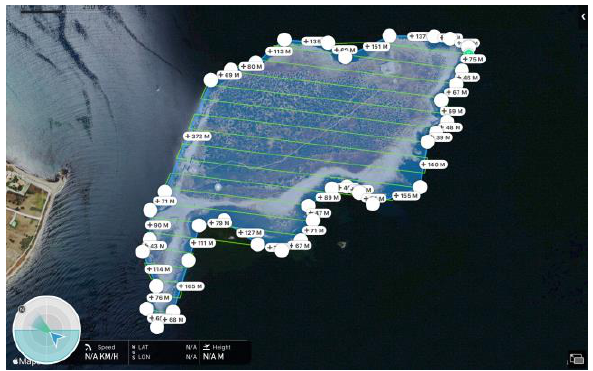
Figure 6. Drone flight path over Capo Passero